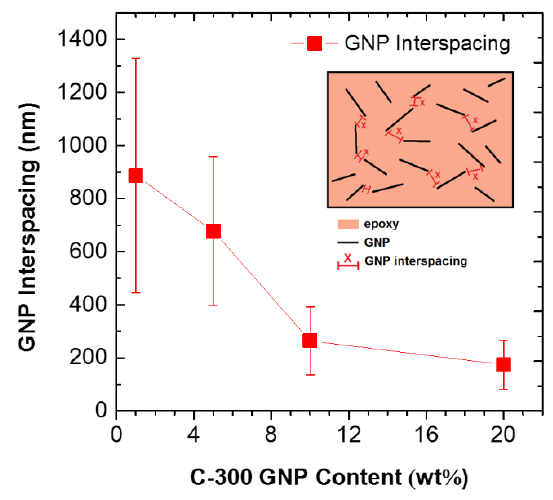
Figure 5. GNP interspacing after milling at varying GNP (C-300 series) content in epoxy nanocomposite.